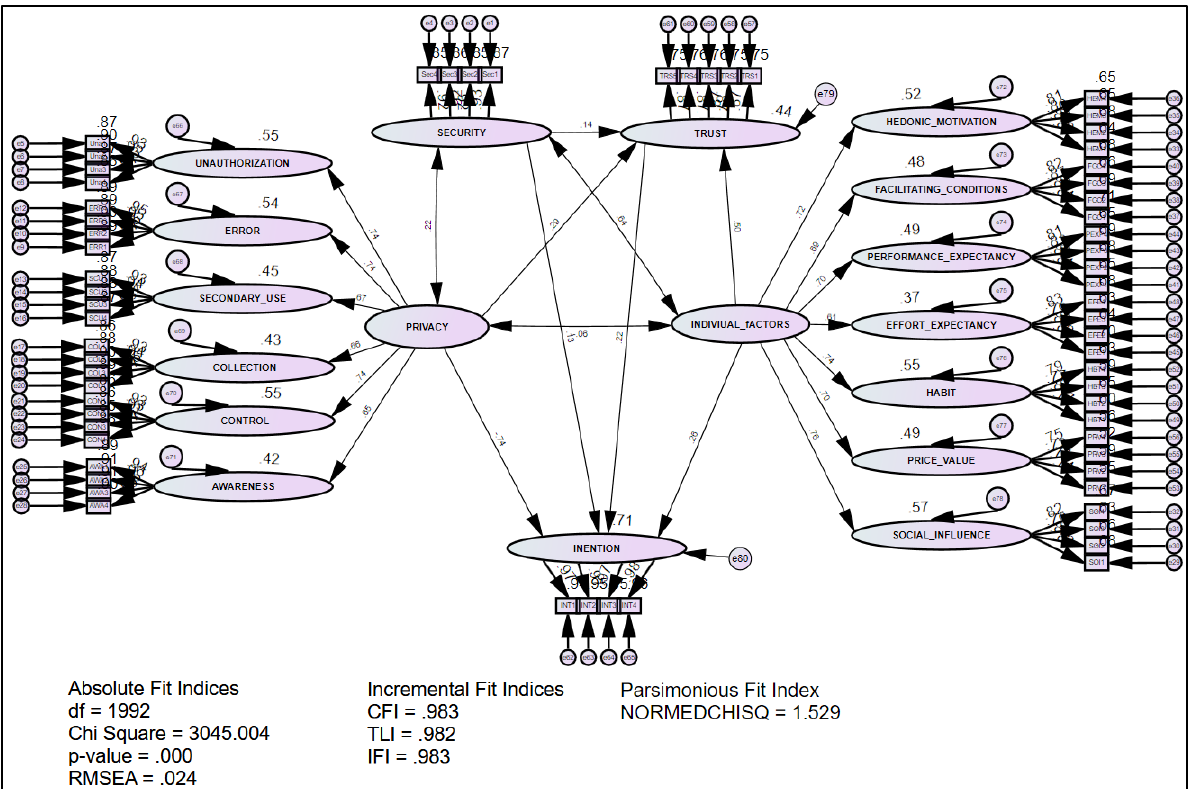
Figure 3. The Structural Model